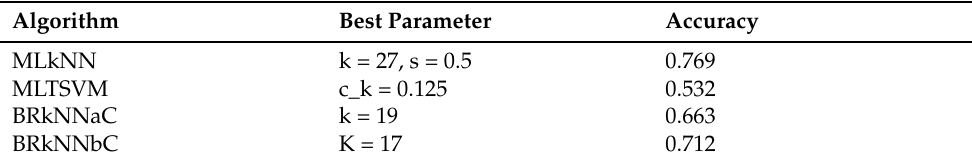
Table 2. Comparison of the performance of MLTC algorithms.